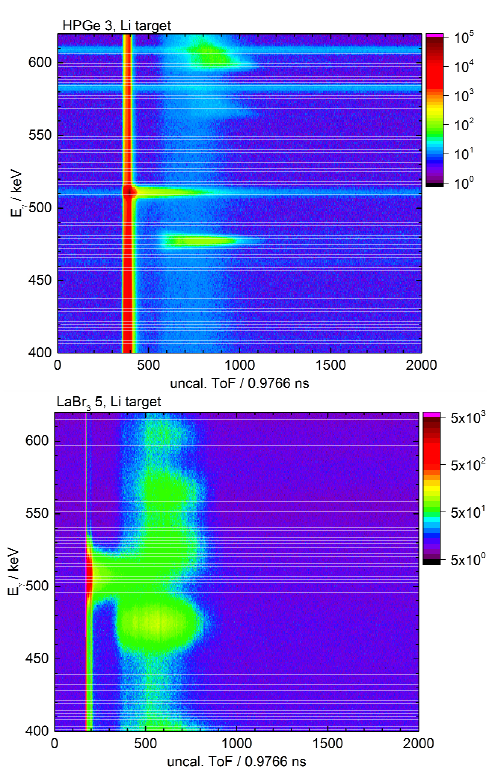
Figure 6. Energy vs. ToF spectra for a HPGe (top) and a LaBr 3 detector (bottom).